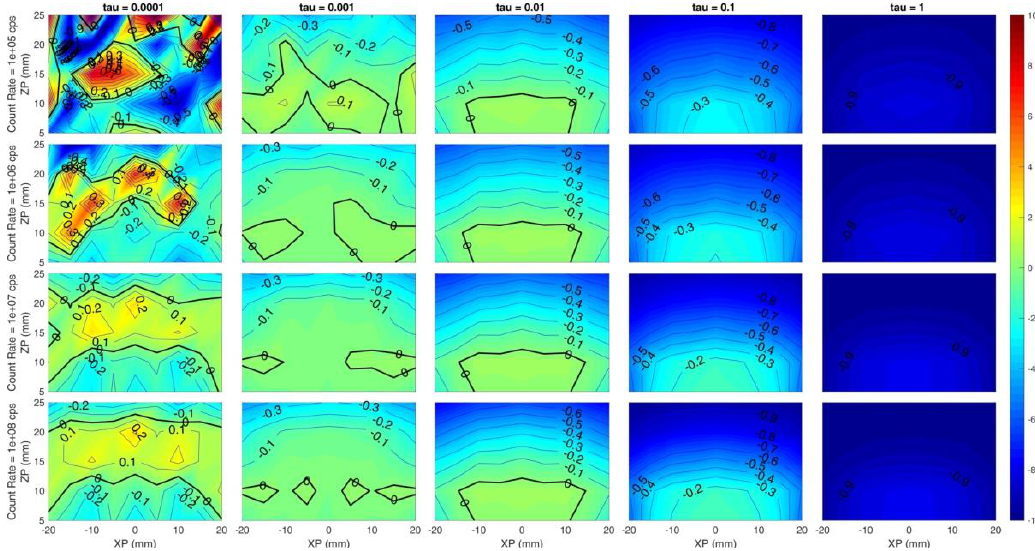
Figure 5. Volumetric error on the absorption coefficient for different count-rates (rows) and 𝜏 (columns). Horizontal axis of each subplot is the simulated x position of the inclusion and vertical axis is the simulated z position . Colors show an error of − 100% (blue) to +100% (red).